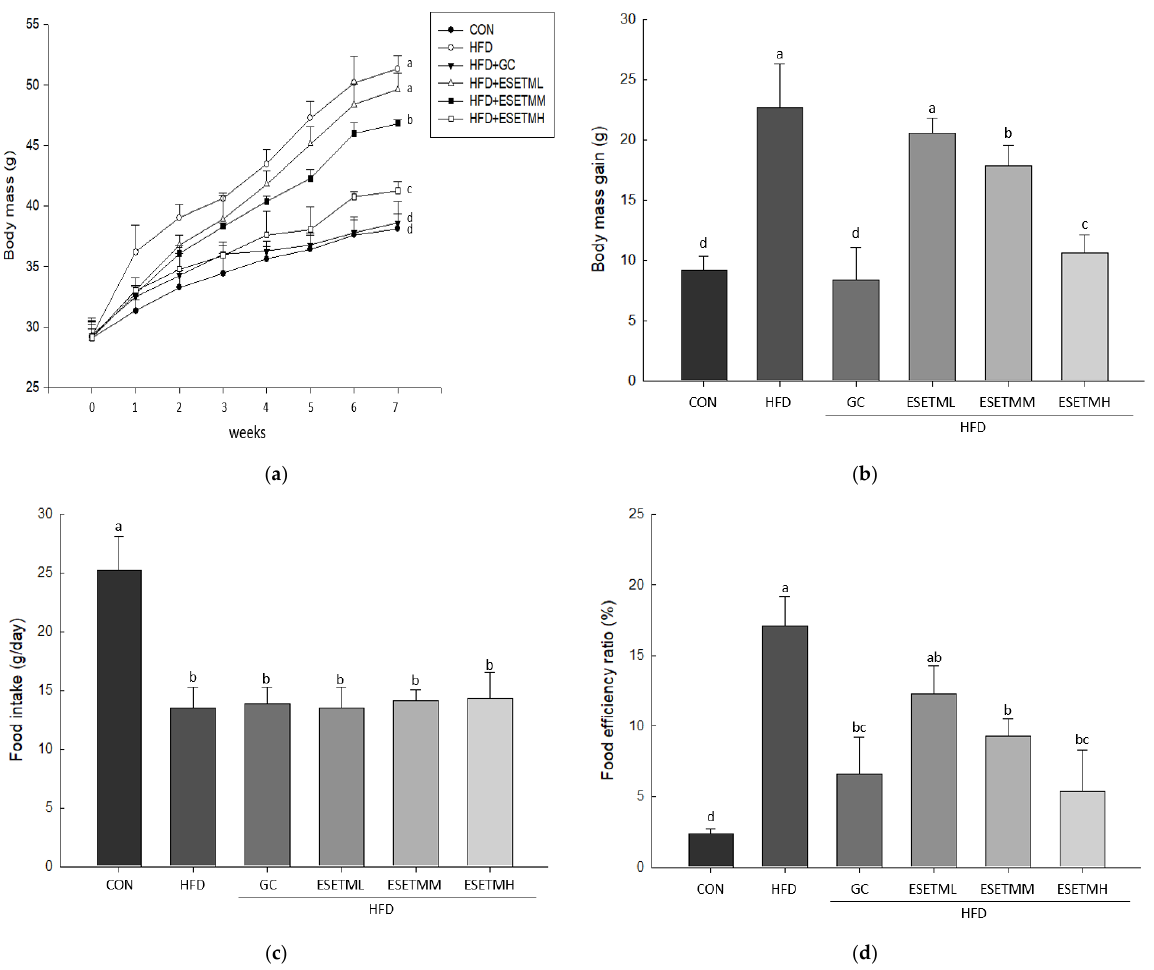
Figure 2. Effects of ESETM supplementation for 7 weeks on body mass ( a ), body mass gain ( b ), daily food intake ( c ), and food efficiency ratio ( d ) in ICR mice fed high-fat diet (HFD). Data are shown as the means ± standard deviation (SD) ( n = 5). Different lower case letters above columns indicate statistical differences at p < 0.05. Table 3. Effects of ESETM serum biochemical analysis in HFD-fed obese ICR